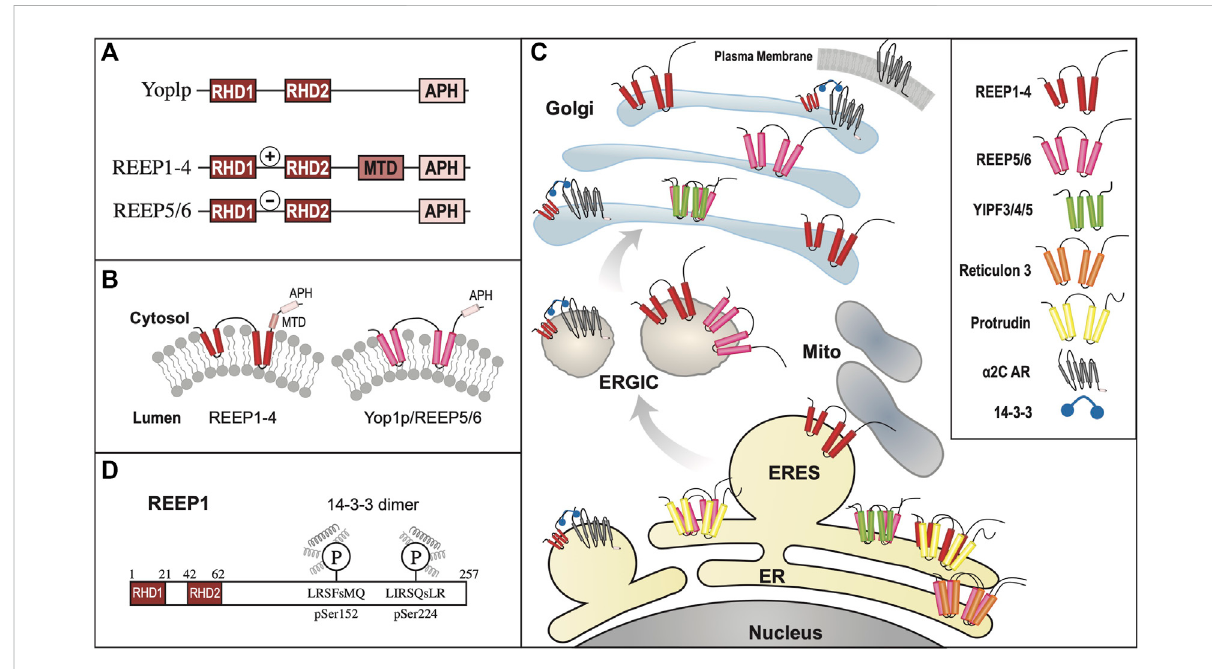
FIGURE 3 REEP/Yop1pFamily ofProteins. (A). Domain structure ofYop1p and REEPs basedon biochemical analyses (Voeltz etal., 2006; Parketal., 2010). Note that REEP1-4 and REEP5-6/Yop1p have similar structural motif but differ in their carboxy termini (Schlaitz et al., 2013). REEP/Yop1p family members have conserved Rtn homology domains ( RHD ) and a carboxy terminal amphipathic helical domain ( APH ). Additionally, REEP1-4, but not REEP5-6/Yop1p, possess a microtubule-binding domain ( MTD ) between RHD2 and APH (Brady et al., 2015). Additionally, REEP1-4 contain a positivelychargedregionbetween RHD1 and RHD2 thatalsointeractswithmicrotubules,whereasREEP5/6possessanegativelychargedregionthat does not interact with microtubules. (B). REEP/Yop1p family members have two conserved RHD domains that insert into the membrane as hairpin structures and a carboxy terminal APH that is either is cytoplasmic or aligned with the membrane (Park et al., 2010). (C). Intracellular localization of various REEP family members is shown within the ER, Golgi, and mitochondrial compartments, The role of REEP1 as a membrane-shaping adapter protein (MSAP) is shown with REEP1 binding to a model cargo protein ( α 2C adrenergic receptor) via an adapter protein (14-3-3 dimer) (Björk et al., 2013). (D). REEP1-4 possess conserved multiple potential Ser or Thr phosphorylation sites, that can bind 14-3-3 protein dimers, potential accessory proteins important for cargo traf fi cking (Tinti et al., 2012). Modeled proteins are not shown to scale relative to their amino acid sequence. ER = Endoplasmic Reticulum, ERES = ER Exit Site, ERGIC = ER/Golgi Intermediate